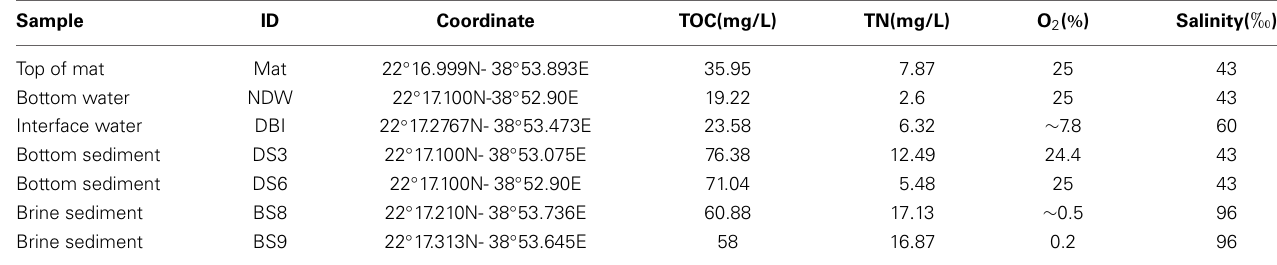
Table 1 | Environmental conditions of the sampling